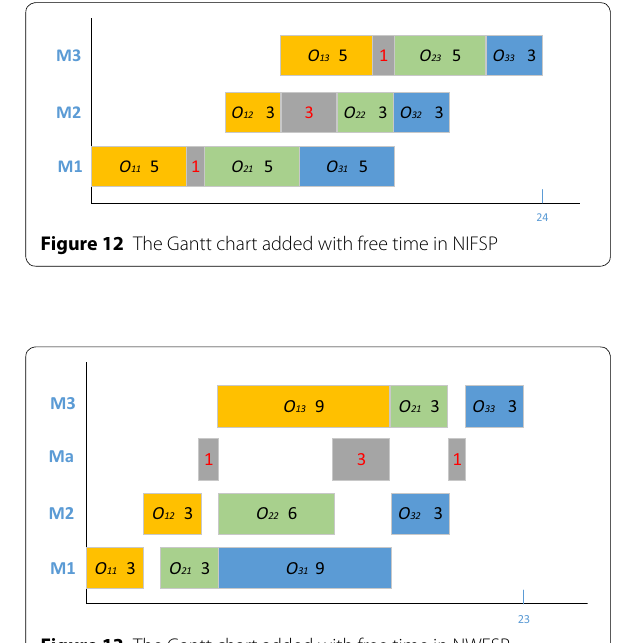
Figure 13, if the operation of O 13 does not process imme- diately when the operation O 12 finishes, the schedule is not the NWFSP. It is also the same situation in NBFSP and SFSP. In another word, the anomalies in special PFSPs can be seen as a way to reduce the completion time by destroying the constraints of the special PFSPs. It is easy to know the lower bound of the anomalies in these special PFSPs is the optimal solution in PFSPs which has the same data with these special PFSPs. Except for the anomalies in scheduling problems, there are also some anomalies in other problems, like